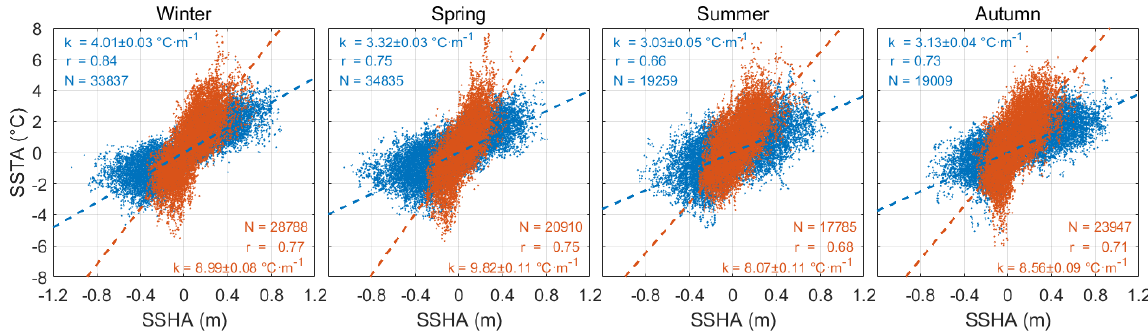
Figure 5. The seasonal scatterplots of mean SSHA and SSTA within matched eddies for the Kuroshio region (blue, the latitudes of 25° – 38°N) and the Oyashio region (orange, the latitudes of 38° – 45°N); the dotted lines are the linear regression of the scatterplots. The regression coefficient k (SSTA/SSHA) with the error denoting its 95% confidence interval, the correlation coefficient r , and numbers N of matched results are labeled in the figure.